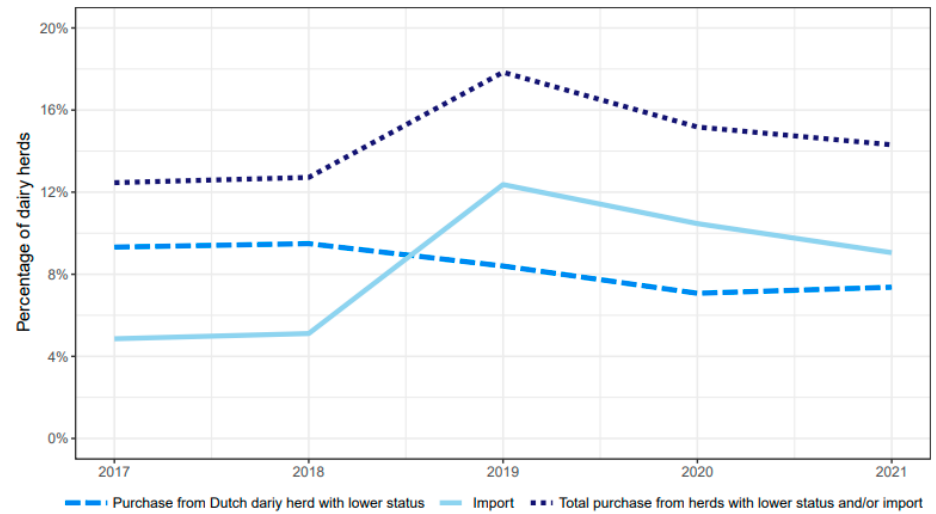
Figure 4. Percentages of dairy herds with a L. Hardjo-free status that purchased cattle from either